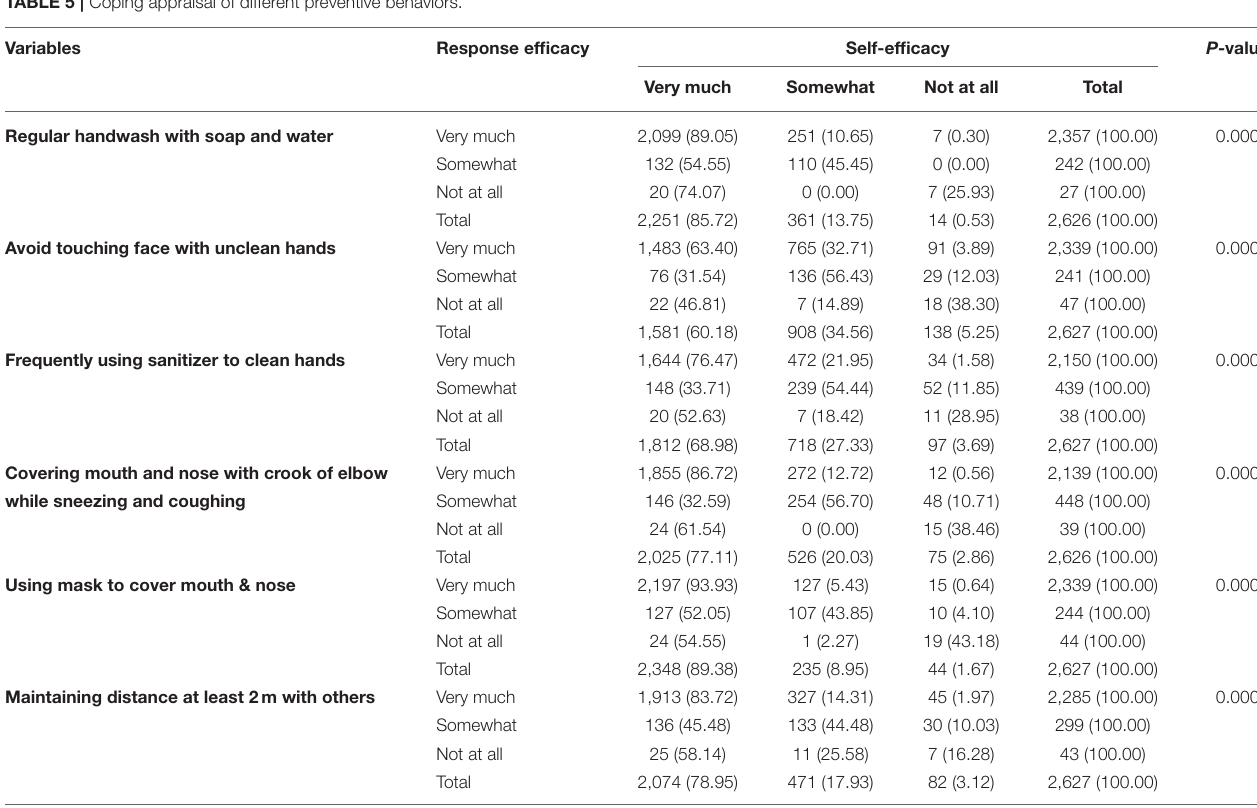
TABLE 5 | Coping appraisal of different preventive